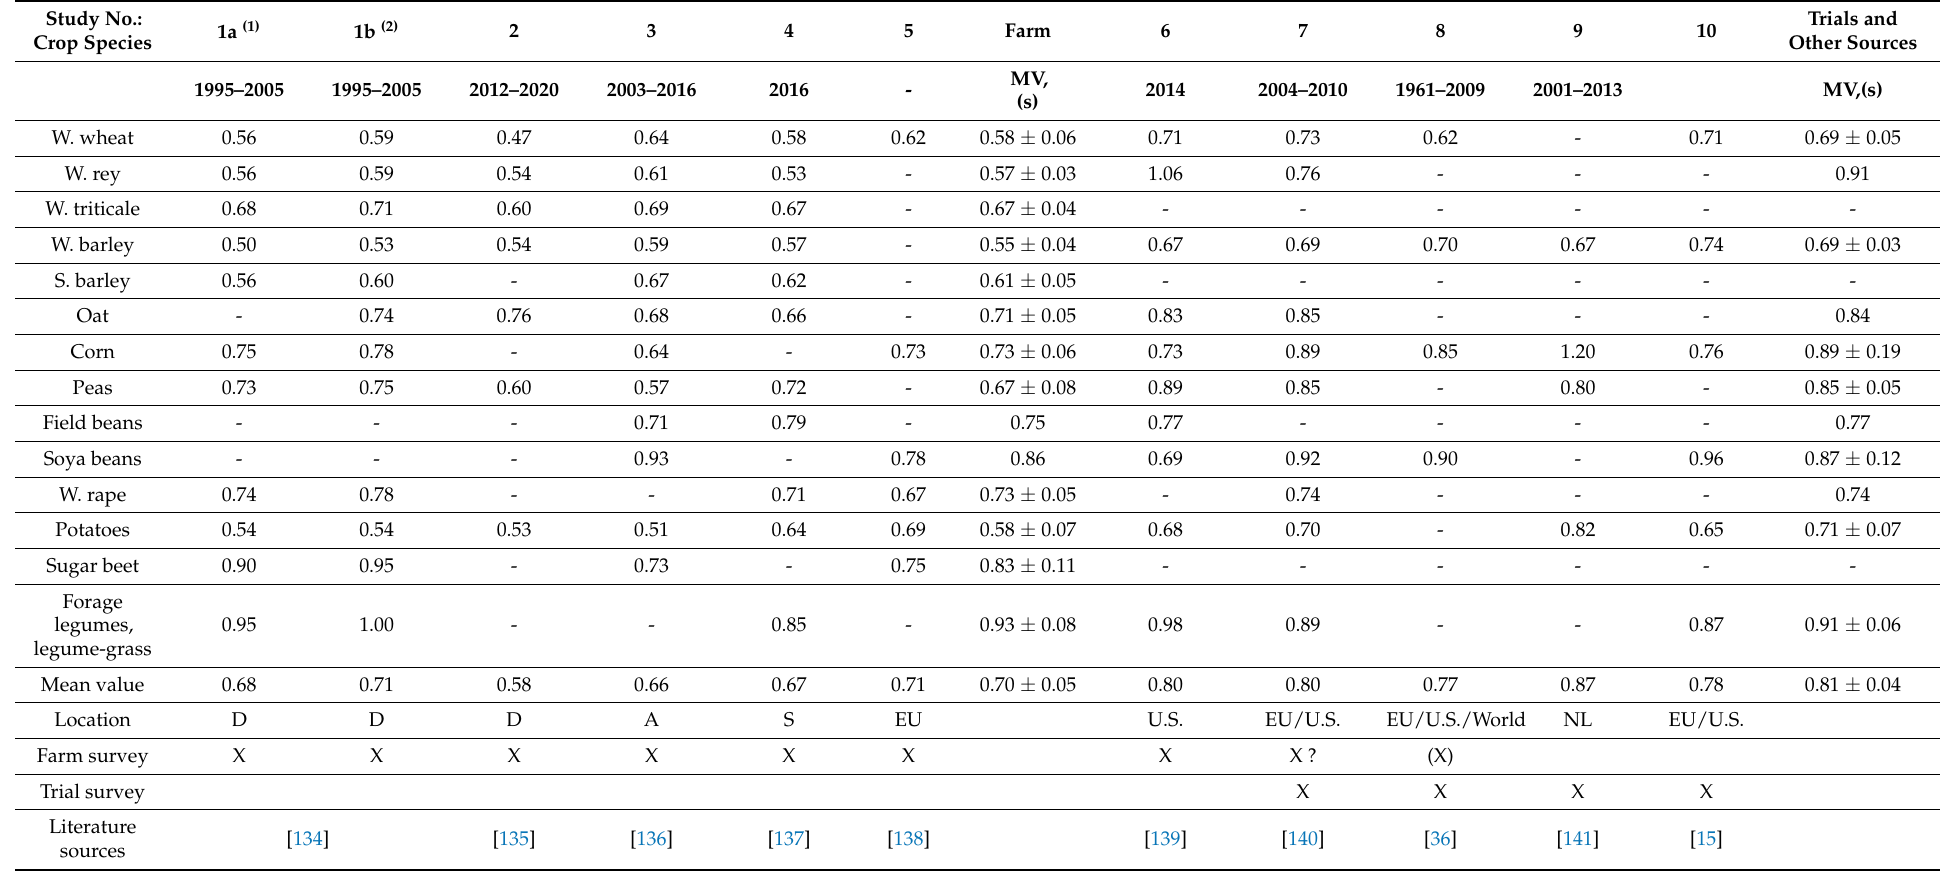
Table 4. Yield differences between conventional and organic cultivation of crop species determined from field surveys and long-term trials (conventional level = 1.0). Study No.: Crop